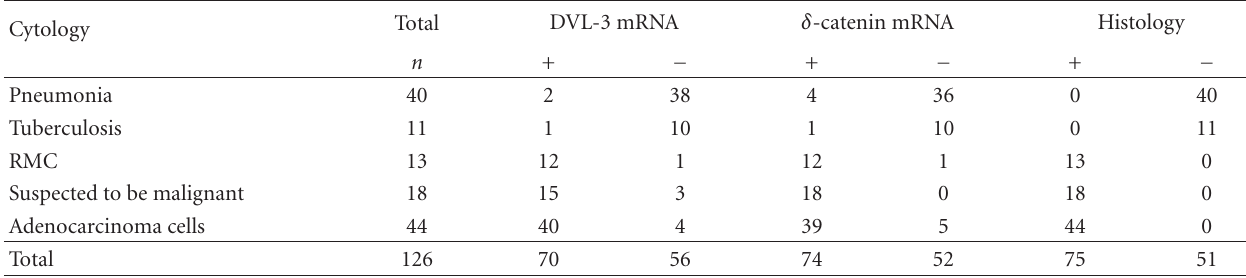
Table 3: Results obtained by cytological assessment as compared with those obtained by RT-PCR for DVL-3 mRNA and δ -catenin mRNA or by histology in pleural e ff usions specimens from patients with benign or malignant lung lesions. Cytology